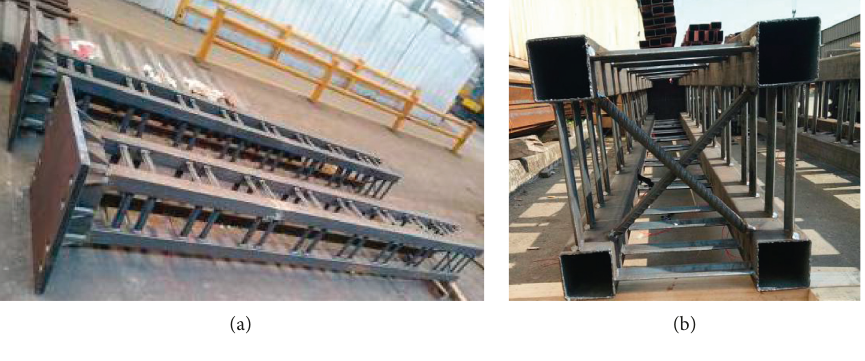
Figure 2: Test components photos.